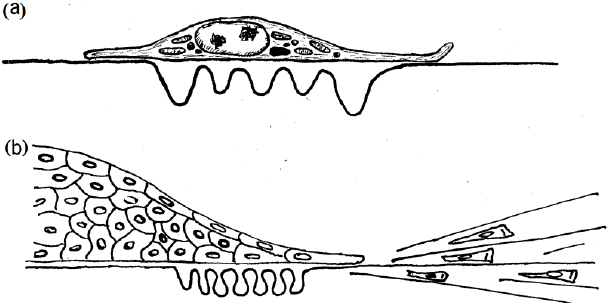
Figure 3. Diagrammatic view of traction force exerted by cell. ( a ) Diagrammatic side view of an individually cultured fibroblast distorting and wrinkling the elastic silicone substratum upon which it has spread and crawled. ( b ) Diagrammatic side view of the margin of an explant whose cells are spreading outward on a silicone rubber substratum. The traction forces exerted by the outgrowing cells compress the rubber sheet beneath the explant and stretch it into long radial wrinkles in the surrounding area. (Reproduced with permission from [26]).